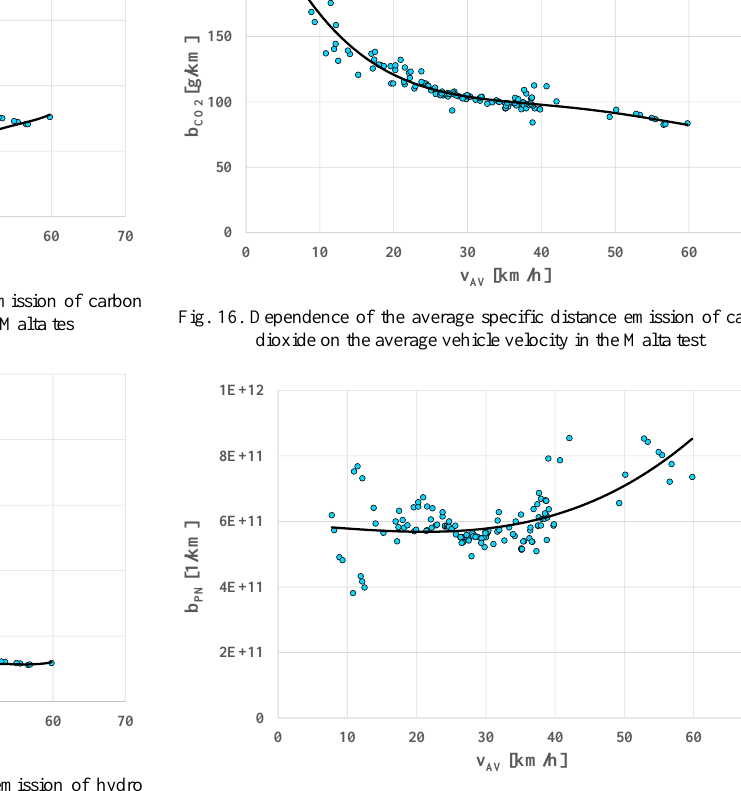
Fig. 17. Dependence of the average specific distance particle number on the average vehicle velocity in the Malta